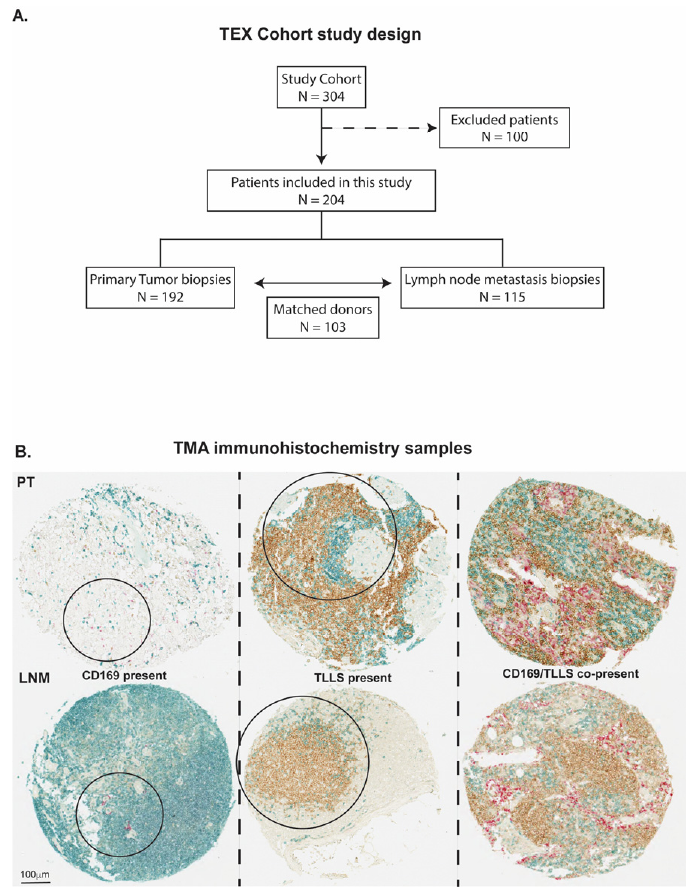
Figure 1. The TEX cohort study design flow chart and immunohistochemical staining examples from the cohort. ( A ) 204 patients were included from the retrospective TEX cohort, giving altogether 192 primary tumor and 115 lymph node metastasis biopsy samples; excluded patients lacked or had missing biopsy cores. ( B ) Tissue microarray (TMA) sections and immunohistochemistry using the three markers CD169 (red), CD20 (brown) and CD3 (blue). The staining panel allowed for identification of three types of cell infiltration/presence patterns, which are highlighted in circles, in primary tumors (PTs) and lymph node metastases (LNMs); CD169 + macrophages only (CD169 + ), tertiary lymphoid-like structures only (TLLS), and CD169 + macrophages together with TLLS (CD169 + /TLLS).